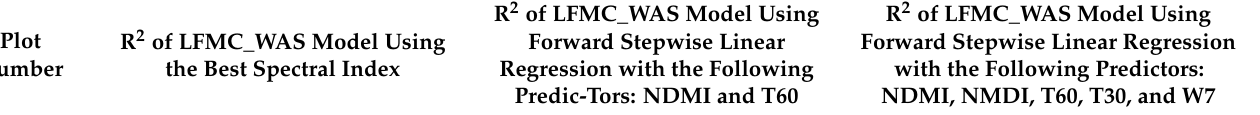
Table 4. R 2 for several linear regression models using LFMC_WAS as dependent variable. The first column refers to the plot number according to Table 1. The second column shows R 2 for the best spectral index. The third and the last columns show the R 2 and the selected variables after applying a forward stepwise regression analysis using NDMI and T60 in column 3 or NDMI, NMDI, T60, T30, and W7 in column 4 ( p -value < 0.05). T60 and T30 are the average of daily mean temperatures calculated in 60 and 30 days, respectively, prior to the date of LFMC_WAS collection in the field. W7 is the average of the mean wind speed for 600 s of the maximum daily wind gusts for the previous 7